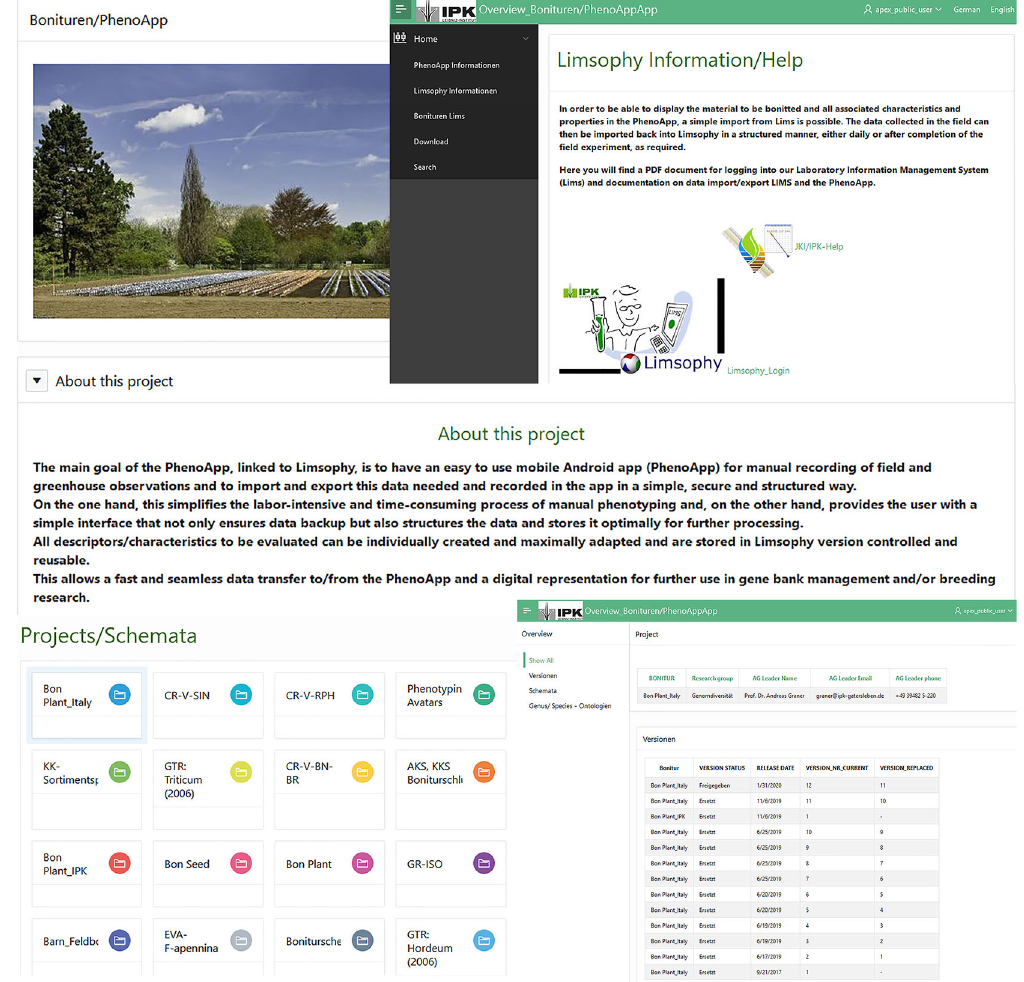
Figure4.OverviewoftheLeibnizInstituteofPlantGeneticsandCropPlantResearch(IPK)internApex(Oracle ApplicationExpress)application.